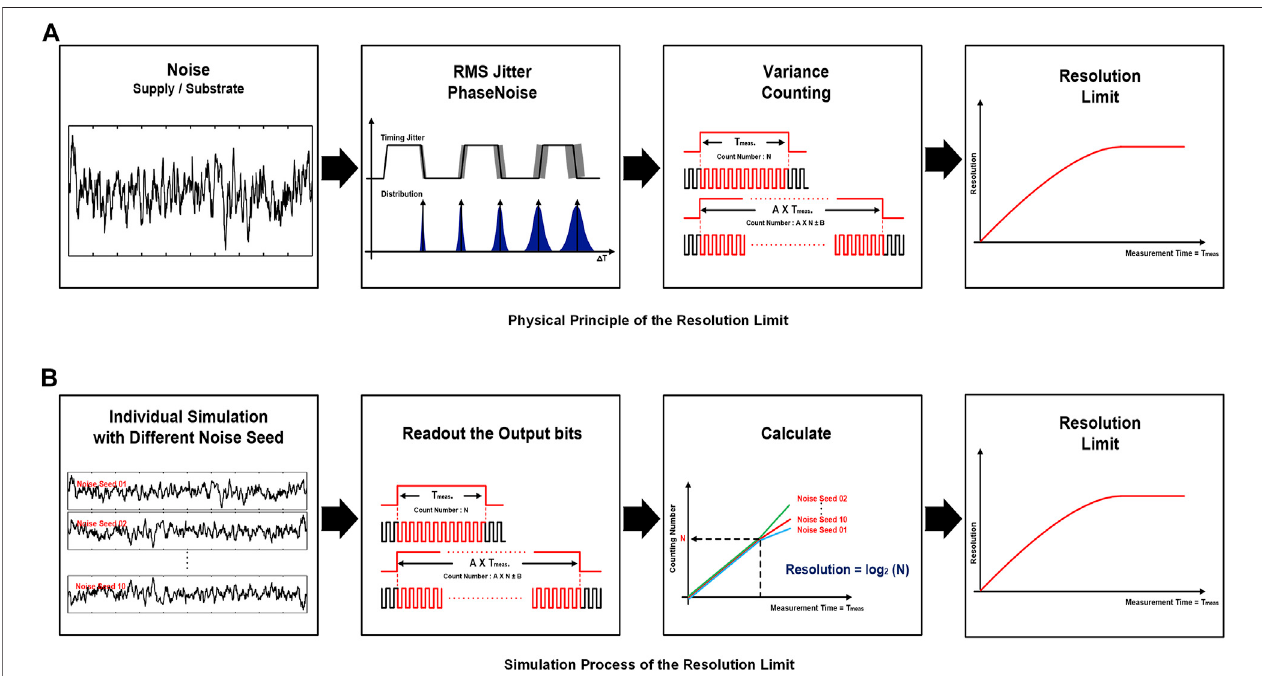
FIGURE 8 | System-level simulation steps for the time-based RDC: (A) physical principle of the resolution limit and (B) simulation process to get the maximum bit- resolution.